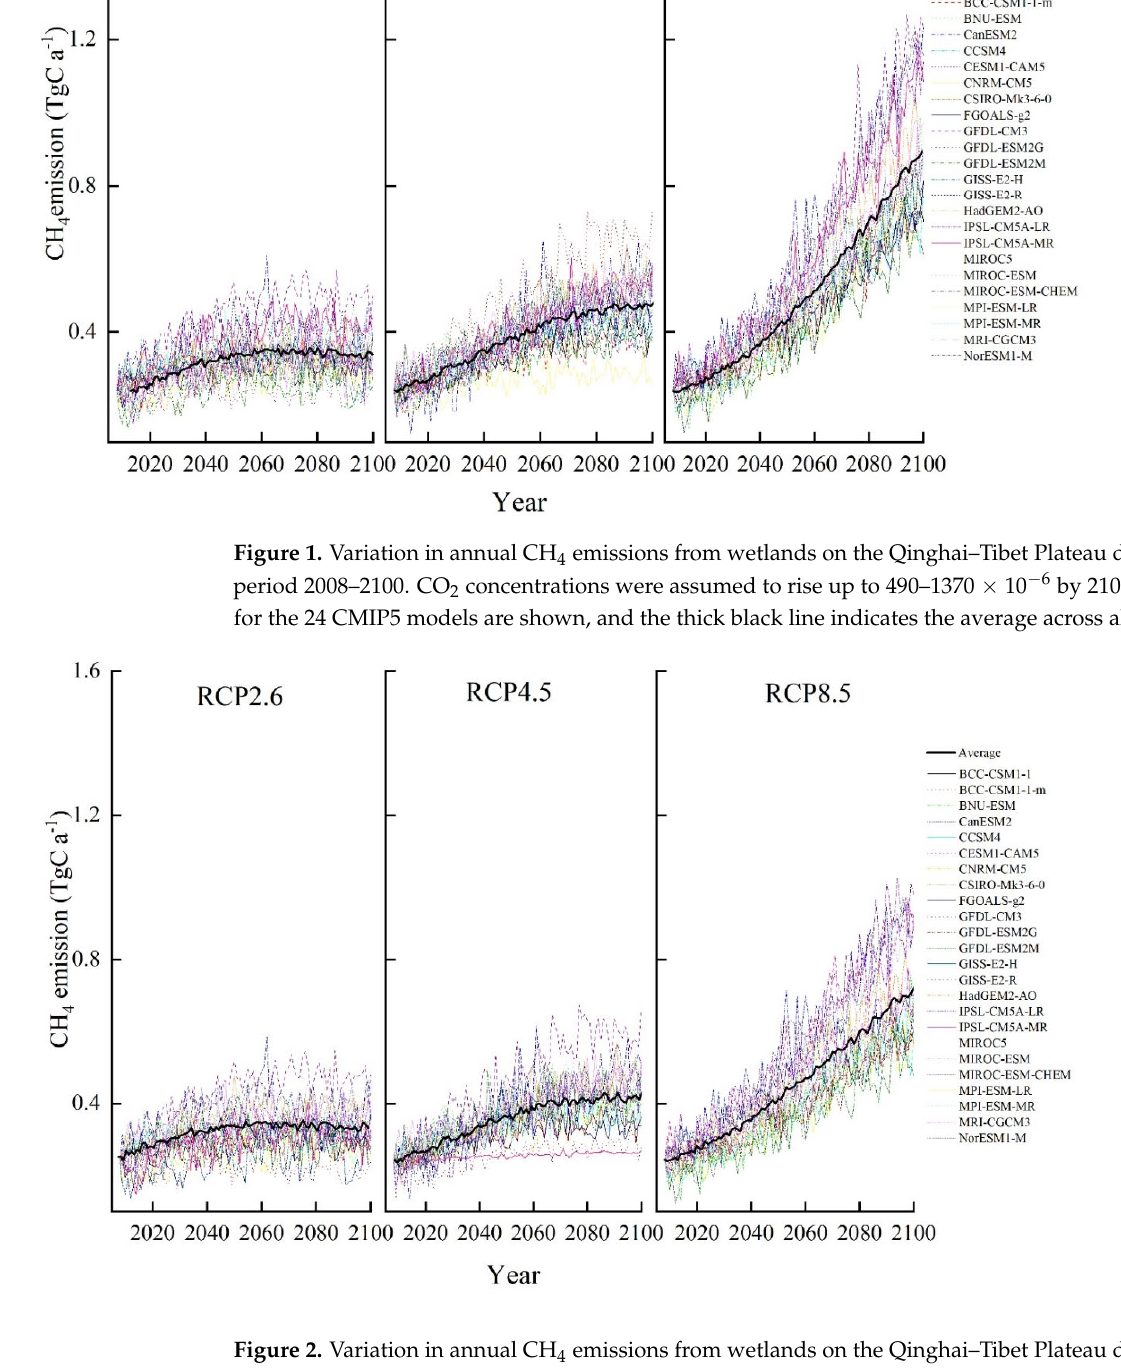
Figure 3. Difference in average CH 4 emission from wetlands when models stipulated increasing or constant CO 2 . Average values were calculated across all 24 CMIP5 models, and results under each RCP are shown. Positive differences indicate higher average emission with increasing CO 2 .